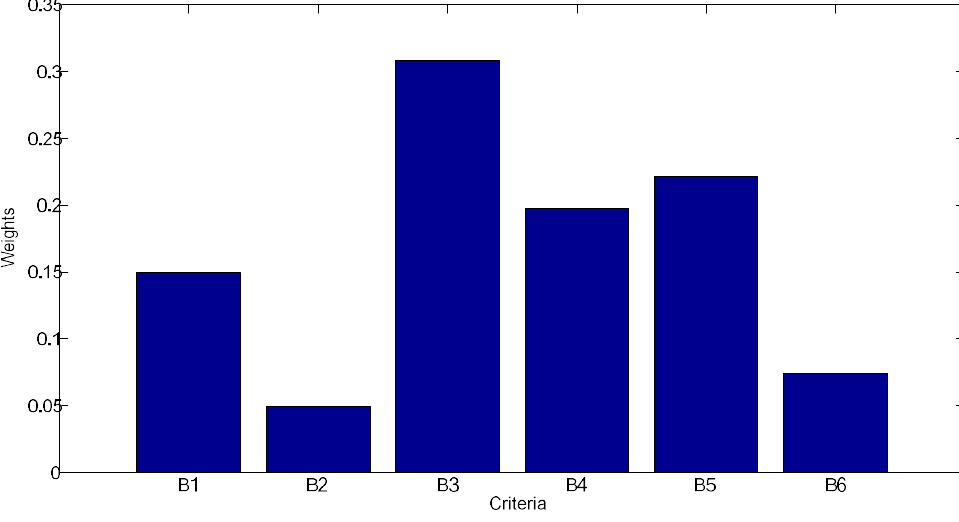
Figure 1. Criteria weighting coefficients.